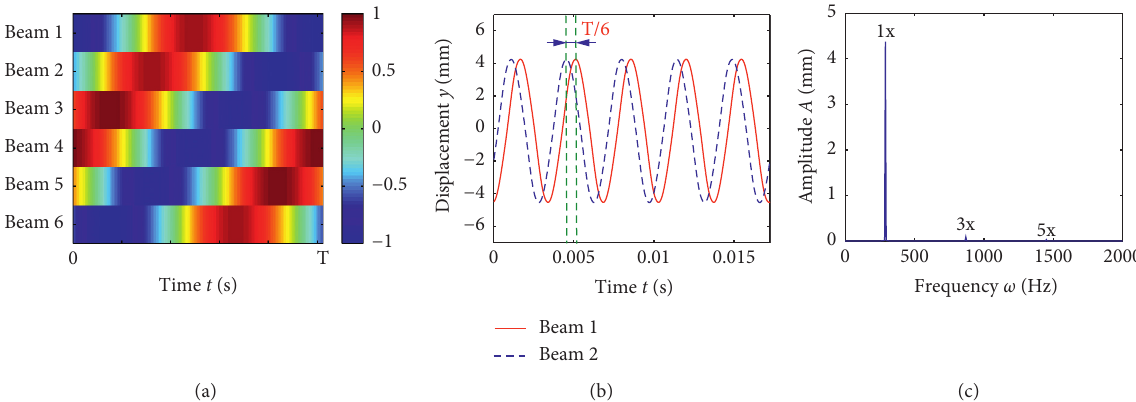
Figure 19: The response of beam tip for μ � 0.3: (a) response of beam 1 to beam 6, (b) response curve of beams 1 and 2, and (c) spectrum plot of beam 1.